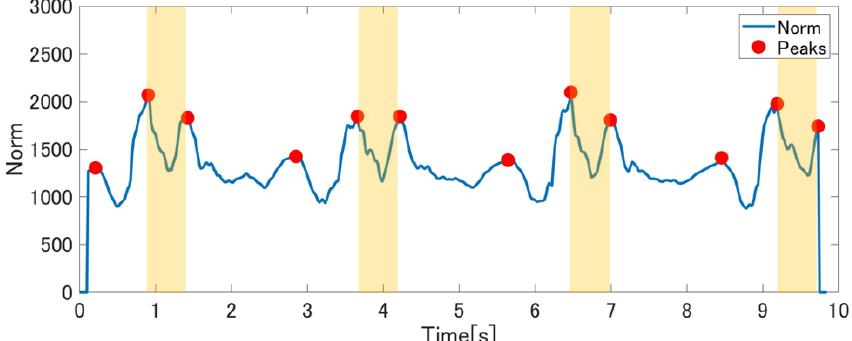
Figure 4. The smoothed synthetic acceleration signal and detected peaks during sit-ups exercise.